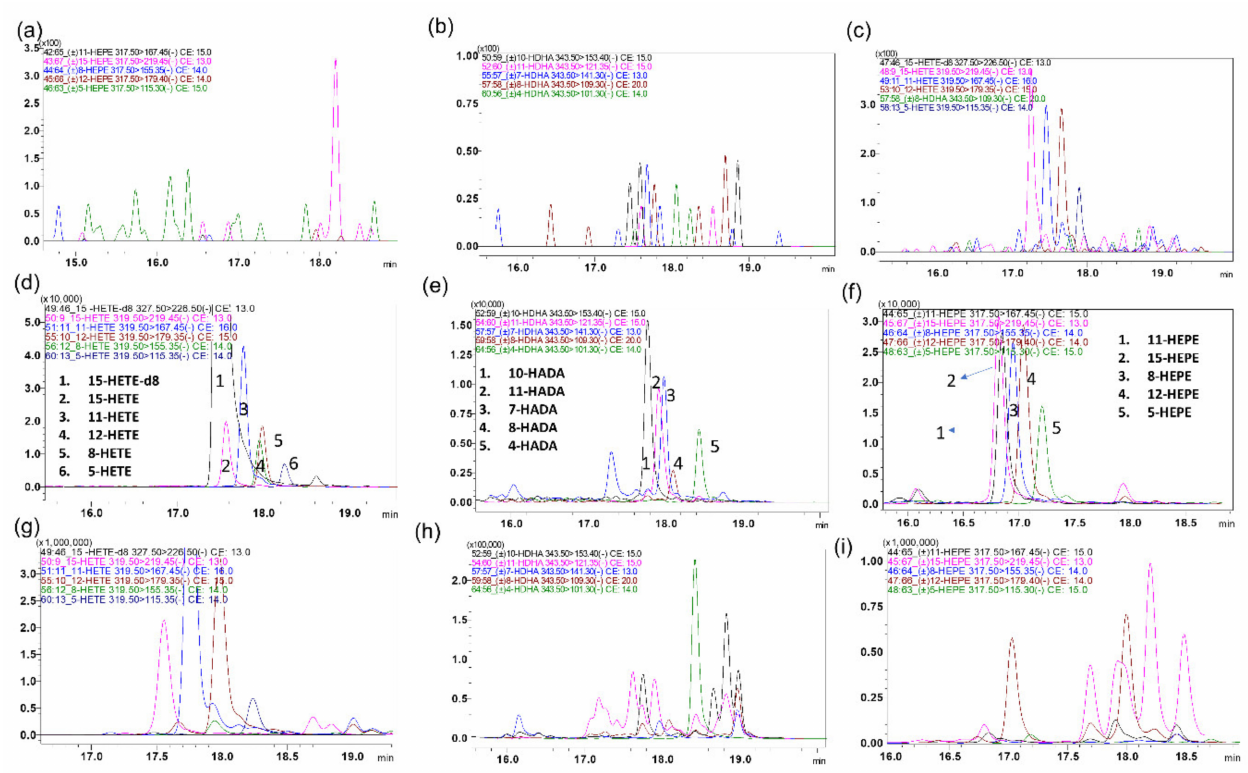
Figure 3. Representative overlay MRM ion-chromatograms of isobaric eicosanoids that share some fragments, as well as retention times, were distinguished via specific MRMs: ( a – c ) blank charcoal-stripped surrogate matrix of selected analytes, ( d – f ) spiked in charcoal-stripped surrogate matrix of selected analytes (0.5 g/mL), and ( g – i ) healthy colon sample of selected